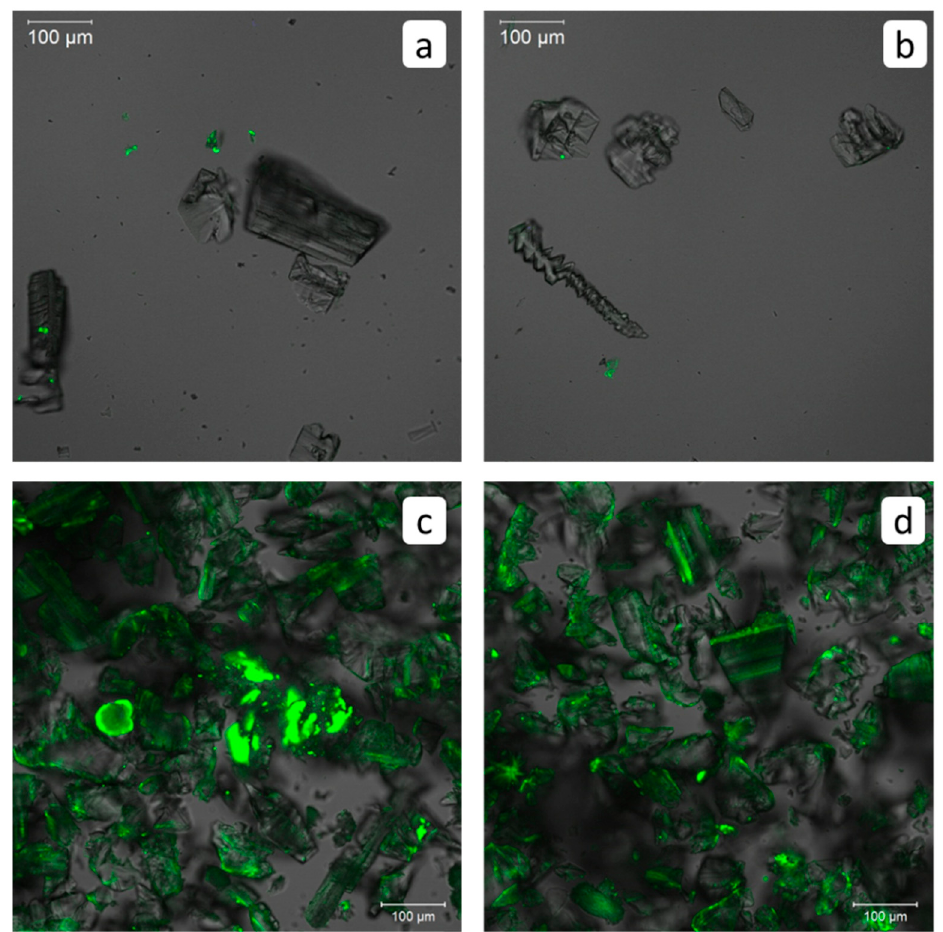
Figure 7. Fluorescent images of the liquid phase of a gypsum solution with 10 mg ⋅ dm − 3 PAA-F2 obtained within the NACE Standard treatment, and taken 1 day ( a , b ) and 10 days ( c , d ) after the experiment. Scale marker corresponds to 100 µm.